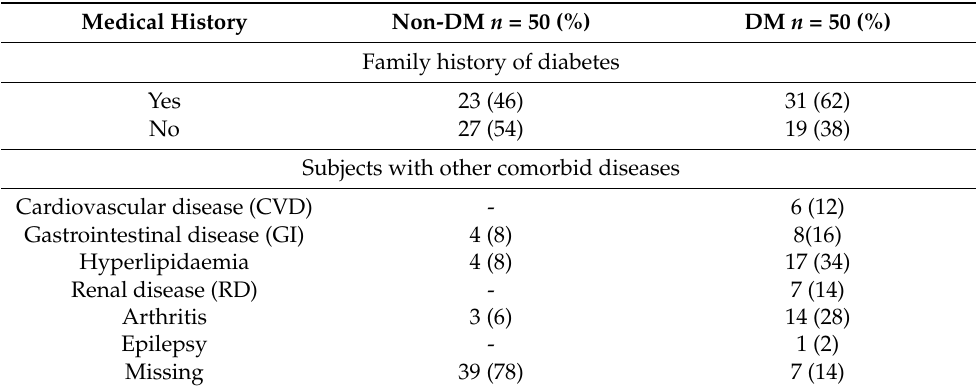
Table 2. Medical history of subjects in non-DM and DM groups.